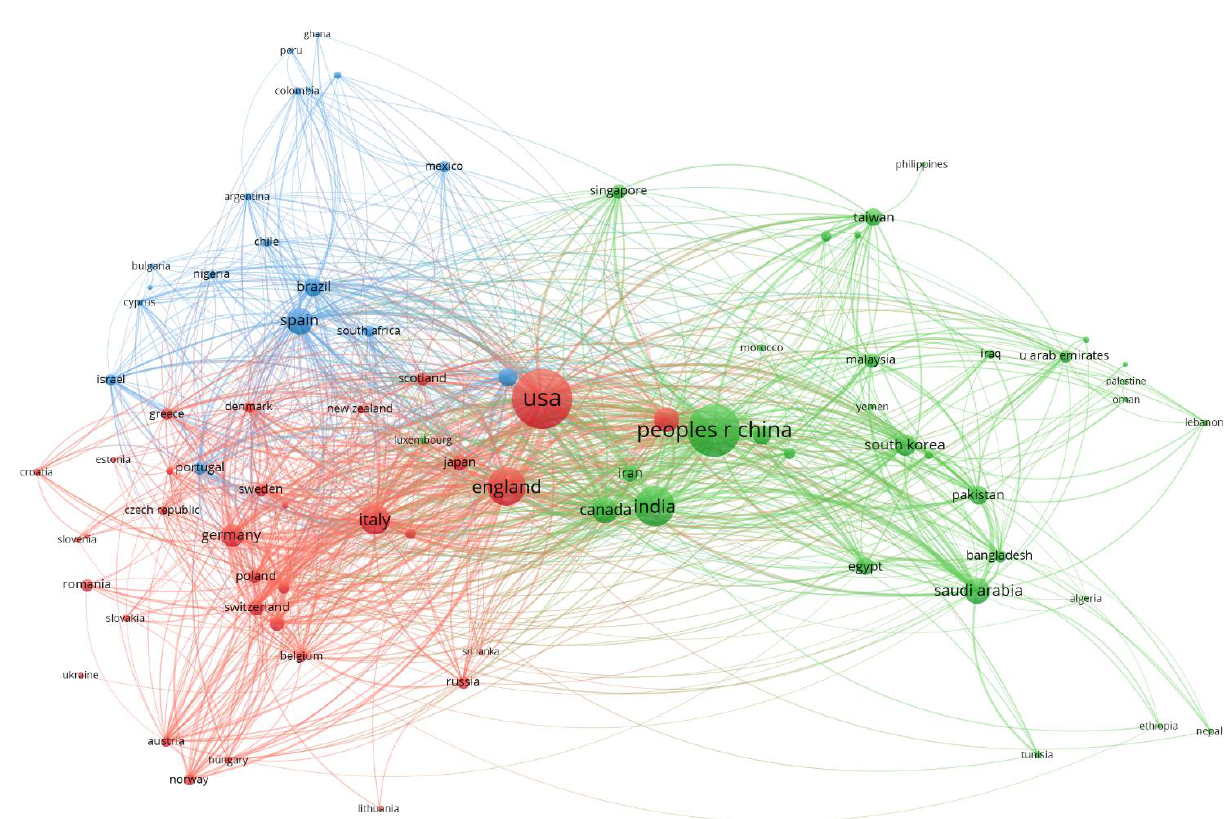
Figure 6. Co-authorships by countries (source WoS).